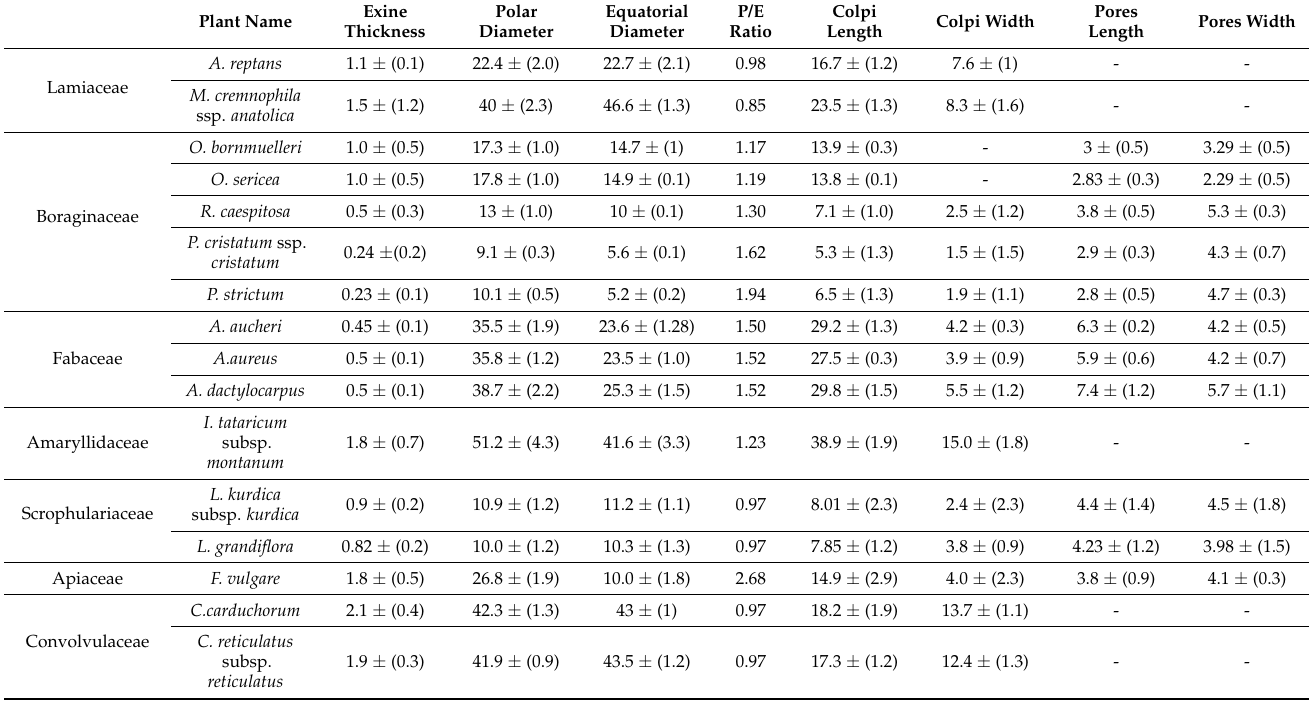
Table 3. Quantitative pollen features via microscopic